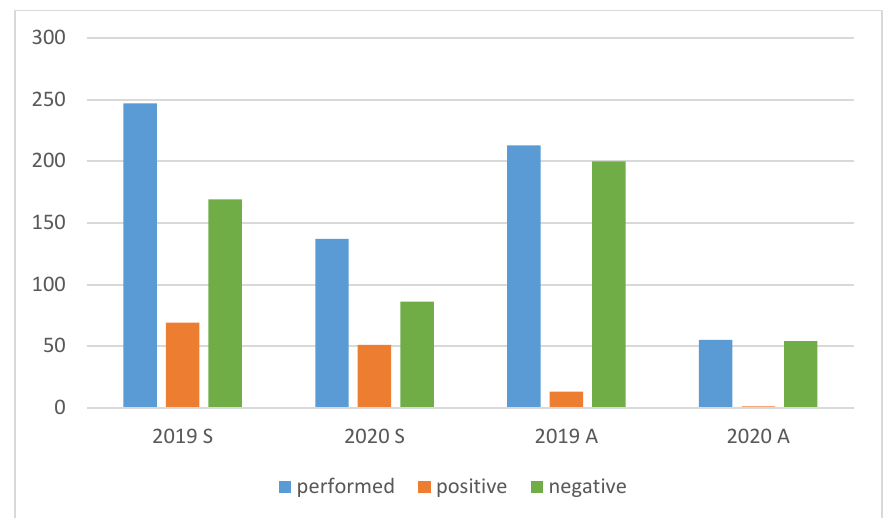
Figure 9. Comparison of RSV tests.